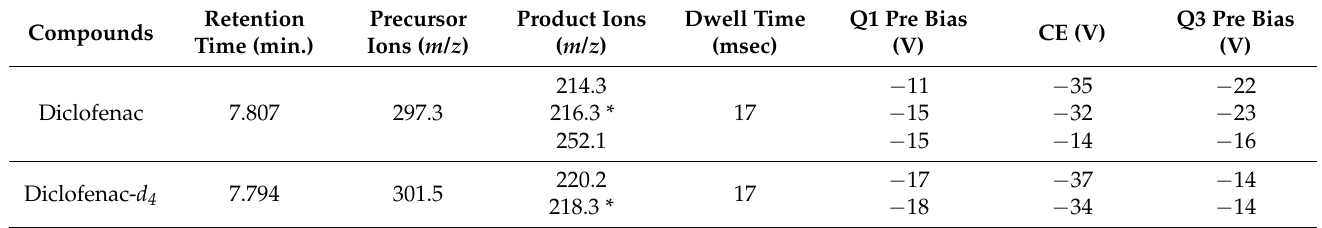
Table 1. UHPLC–ESI-QqQ-MS/MS parameters for diclofenac and diclofenac- d 4 . Compounds